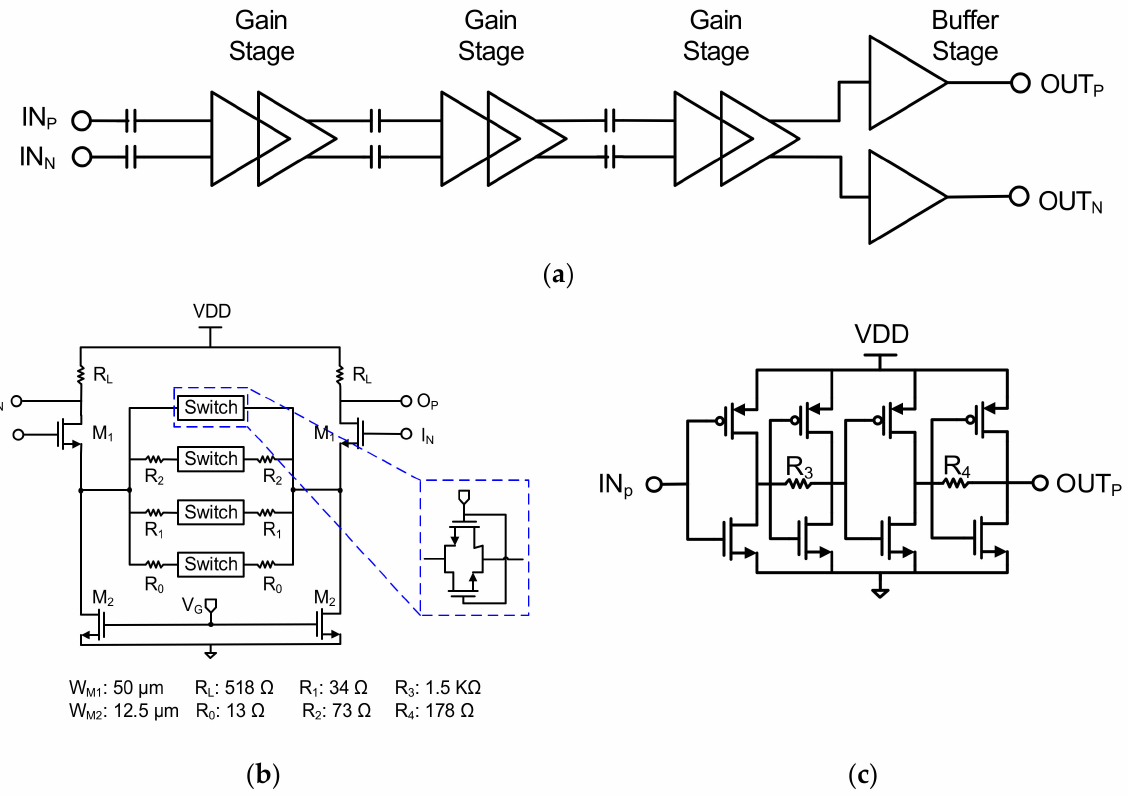
Figure 7. ( a ) Block diagram of 60 GHz baseband amplifier, ( b ) schematic of gain stage, ( c ) schematic of buffer stage of baseband